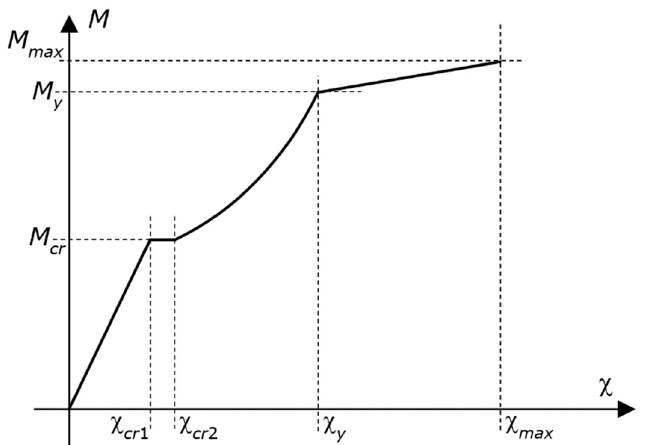
Figure 3. Diagram of the M – χ relationship described by Equations (8)–(10). The figure also shows the